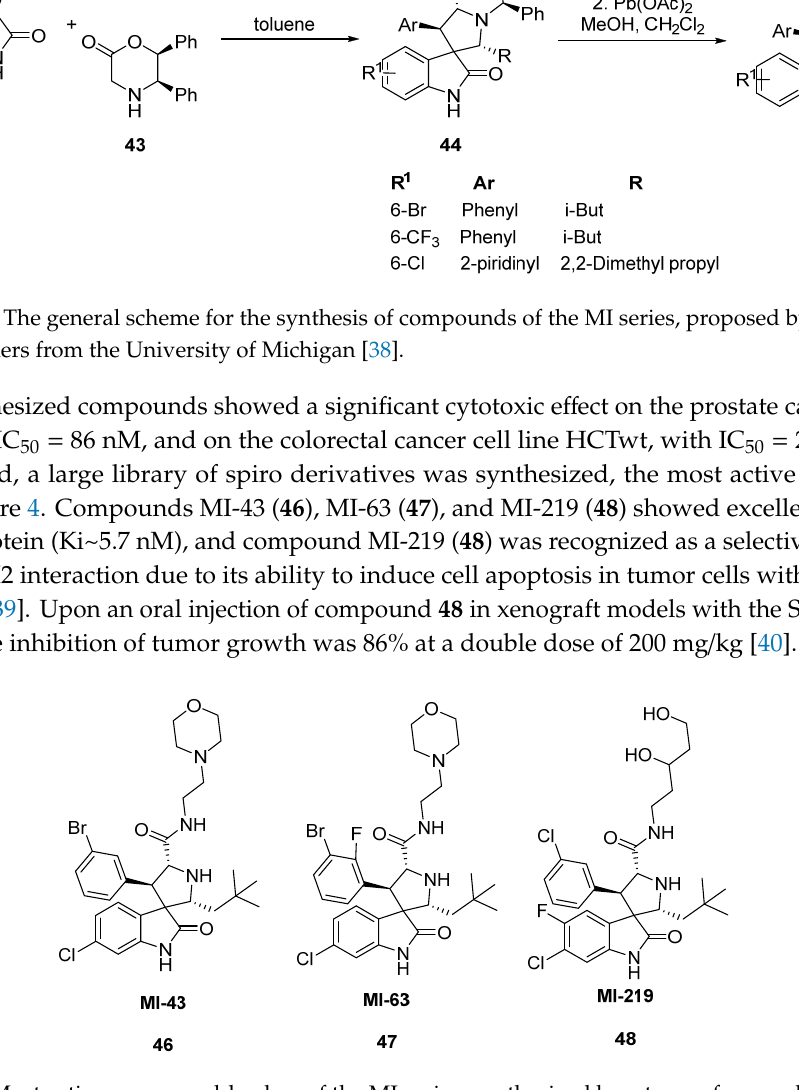
Figure 4. Most active compound-leaders of the MI series, synthesized by a team of researchers from the University of Michigan [39,40].